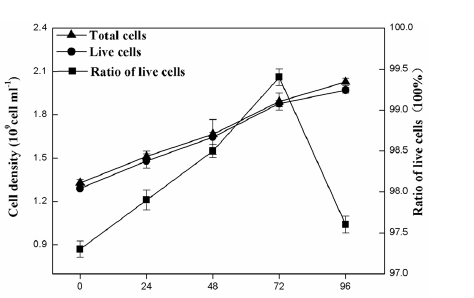
Fig. 6. The live R. palustris grown on landfill leachate with time